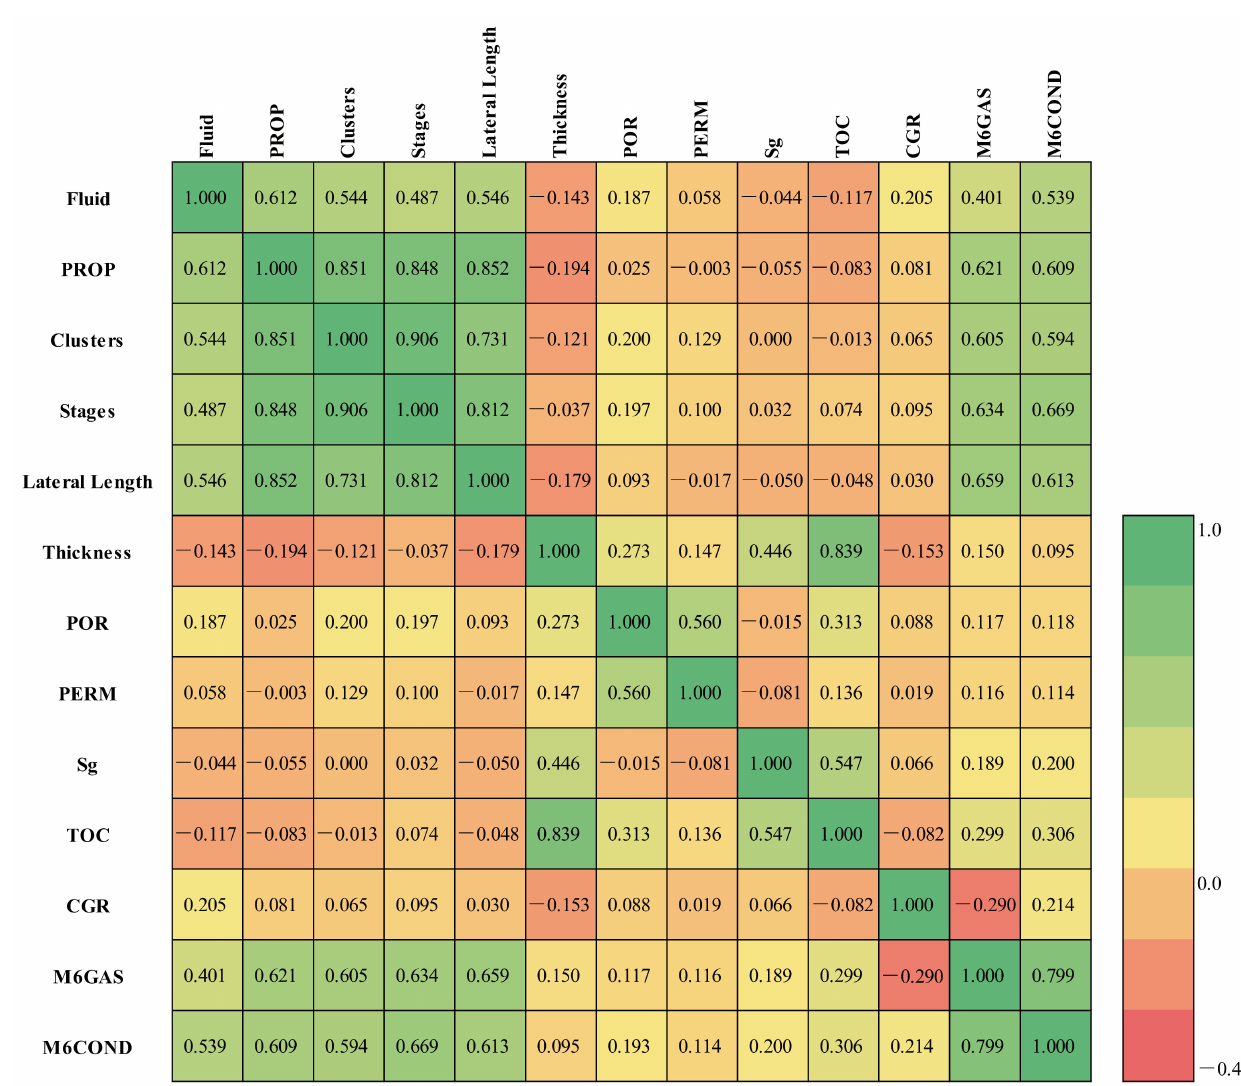
Figure 3. Correlation matrix (Green: positive correlation, Red: negative correlation, the darker the color, the stronger the